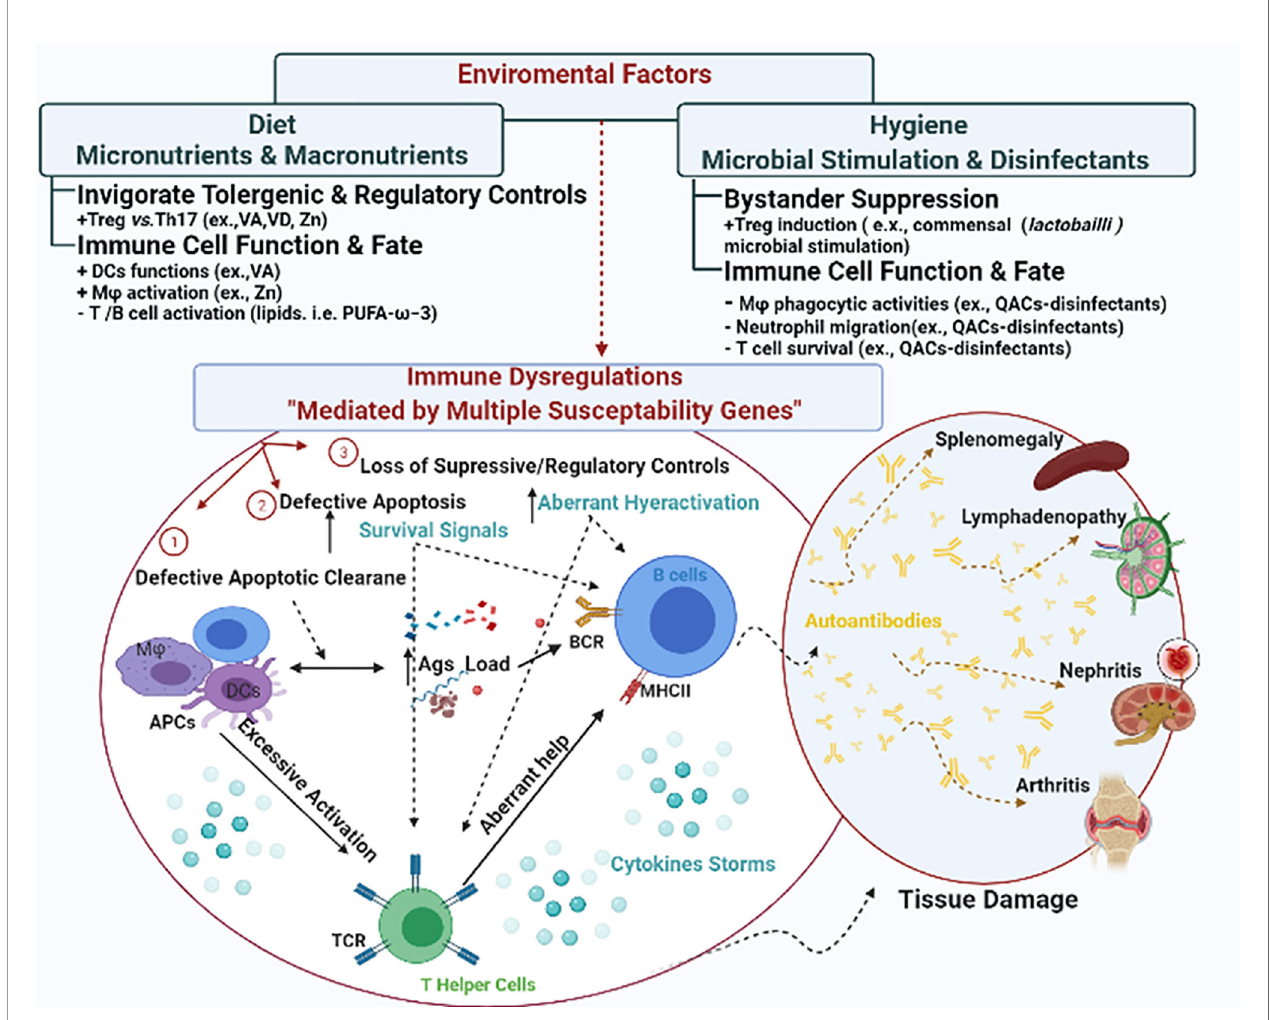
FIGURE 1 | The interplay between environmental factors and genetic susceptibilities in shaping immune dysregulation. Genetic susceptibilities could lead to immune dysregulation via different mechanisms including (1) defective apoptotic cell clearance, (2) defective apoptosis, and (3) loss of suppressive regulatory controls. Collectively they lead to disrupted cytokine signals and hyperactivation of autoreactive T and B cells, invigorating a series of tissue damage in various manifestations. In SLE, the manifestations could be presented as splenomegaly, lymphadenopathy, nephritis and arthritis. Environmental triggers either augment or mitigate these mechanisms to shape the